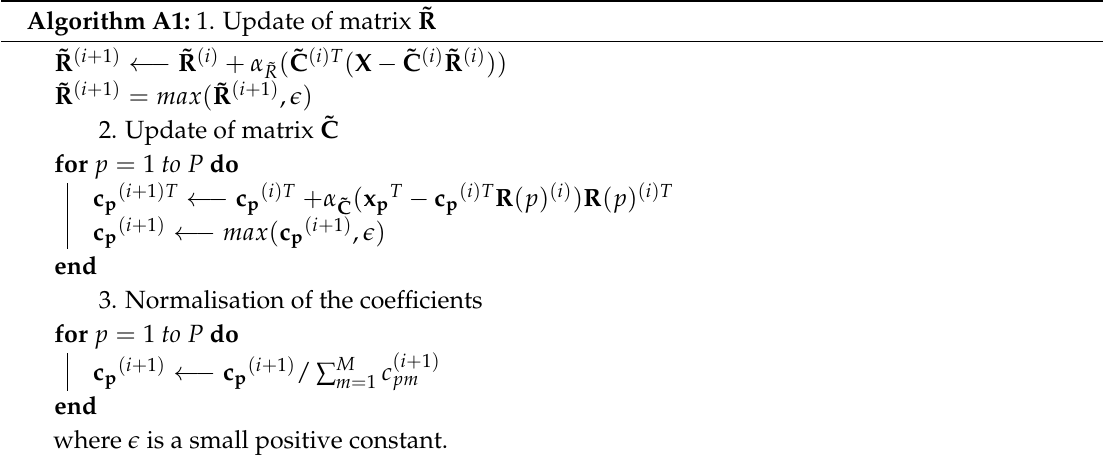
Algorithm A1: 1. Update of matrix